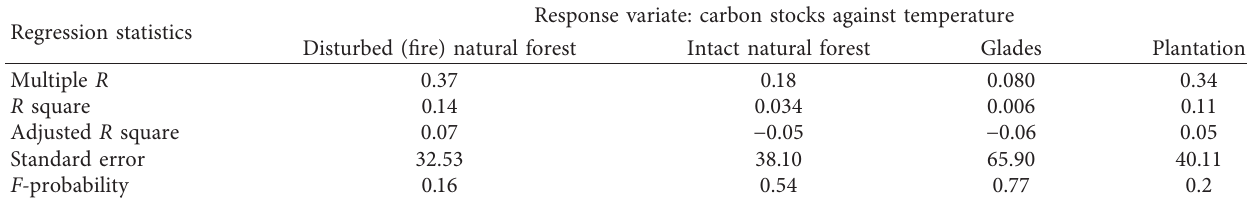
Table 1: Effect of temperature on soil carbon stocks under various forest management types.